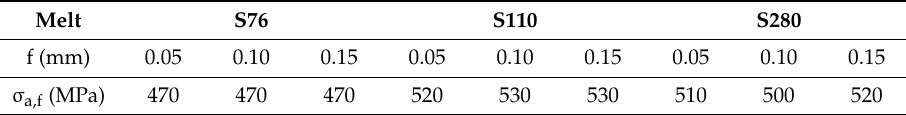
Table 3. Results of load increase tests on 42CrMo4 +